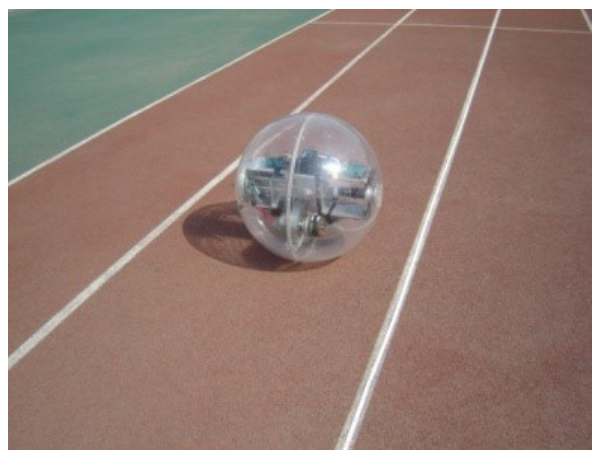
Fig. 6 Hand-joy stick and experiment